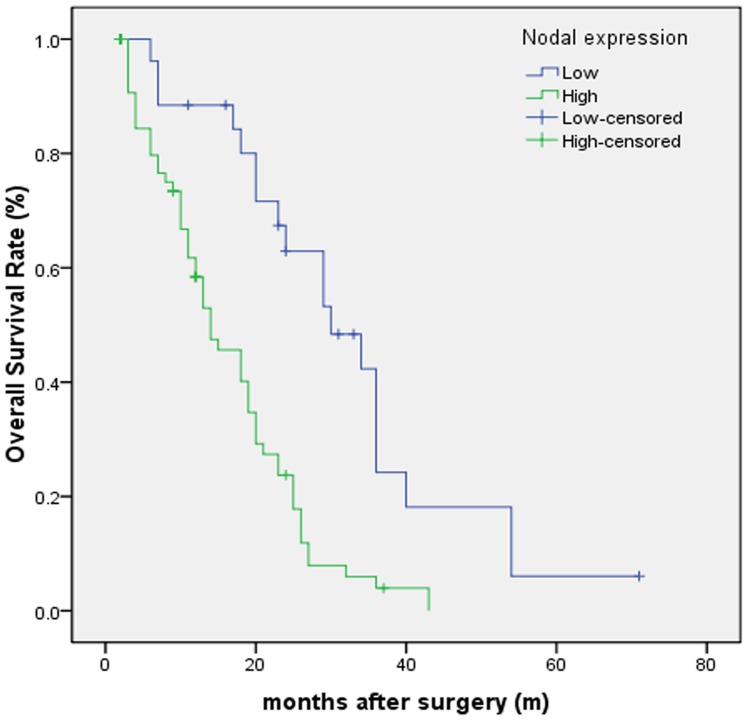
Kaplan-Meier analysis of overall survival curves of patients with HCC according to Nodal expression.The HCC patients with high Nodal expression showed notably poorer overall survival rates than those with low Nodal expression.